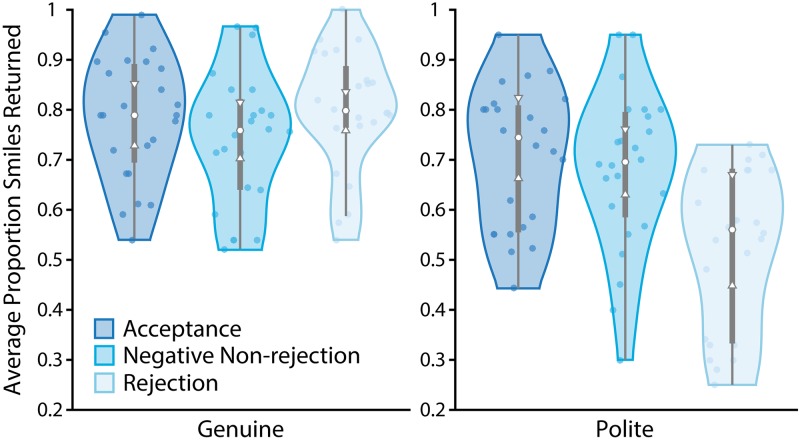
Smile reciprocity.Violin plots showing percent genuine and polite smiles returned in face-to-face interaction depending on participant condition. The grey-shaded central boxes show the inter-quartile range and the whiskers show the 95th percentile of the data distribution. Plot upper and lower boundaries show the full range of the data. The white dots depict the distribution medians while the notches show the 95% confidence interval on the medians. Individual data points are marked with coloured dots on each plot.